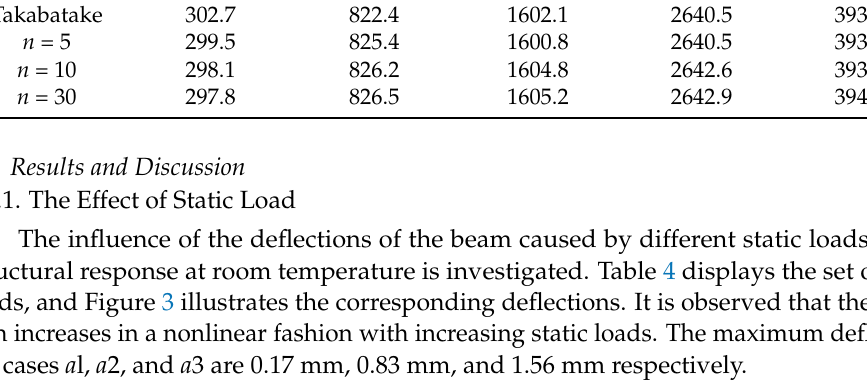
Figure 2. Deflection of a clamped-clamped beam under static load. Figure 2. De fl ection of a clamped-clamped beam under static load. After obtaining an accurate equation for the deflection curve, the linearized modal analysis is compared to that of Takabatake [5]. Takabatake studied the effect of dead loads on dynamic responses of uniform elastic beams using the energy function and assumed modes method. The results are listed in Table 3, with “ n ” representing the number of beam segments in the proposed method. The analysis results are relatively close to those of the literature when n is equal to 5. As the number of segments increases, the mode frequencies gradually converge and n = 30 is chosen for subsequent analysis. Table 3. The first five-mode frequencies of beams under static load (Hz). Modal Table 3. The fi rst fi ve-mode frequencies of beams under static load (Hz).